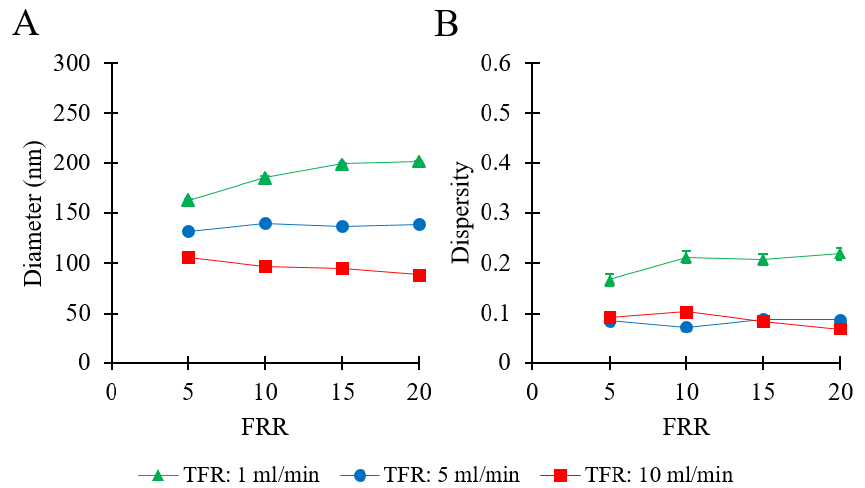
Figure 3. E ff ects of total flow rate (TFR) and flow rate ratio (FRR) on liposome Z-average size ( A ) and dispersity ( B ). Data represent the means of three measurements with corresponding standard